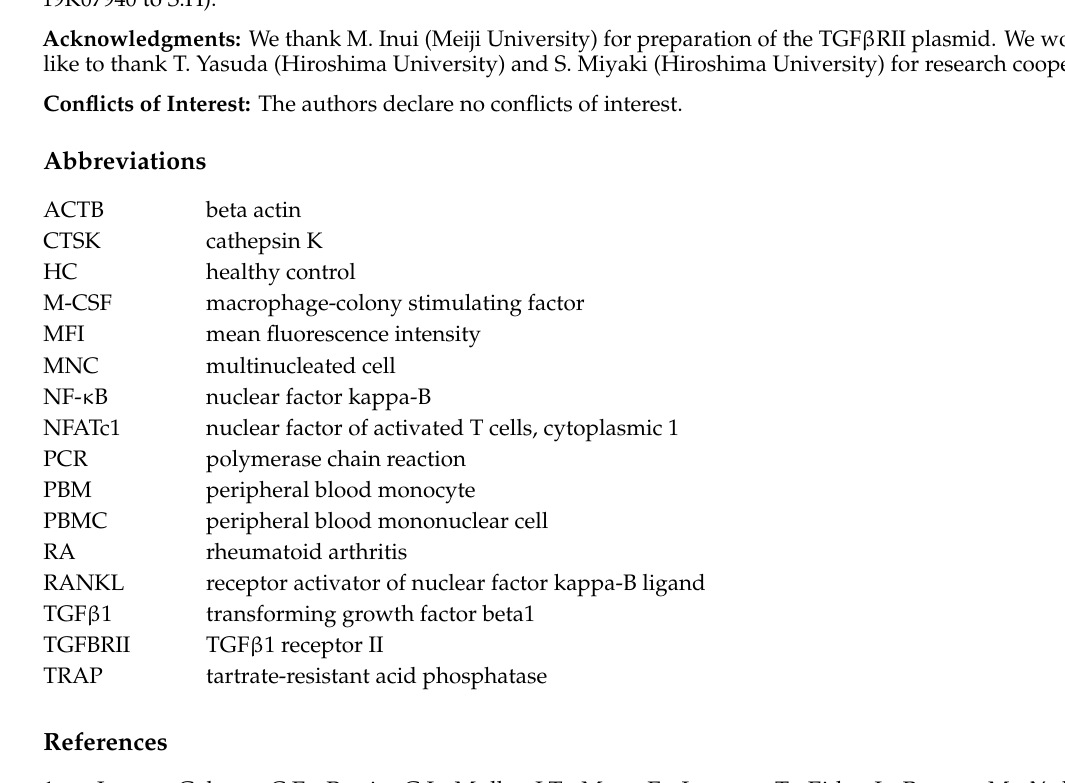
Figure S1: Cytotoxicity of TGF β 1 on human peripheral blood monocytes. Figure S2: The stimulatory e ff ect of TGF β 1 on cell proliferation during osteoclastogenesis. Figure S3: The e ff ect of TGF β 1 on mature osteoclast activity. Figure S4: Di ff erentiation stage-dependent inhibition of osteoclastogenesis and bone resorption by TGF β 1 in humans. Figure S5: Dual luciferase assay revealed the inhibitory e ff ect of TGF β 1 on NFATc1 promoter